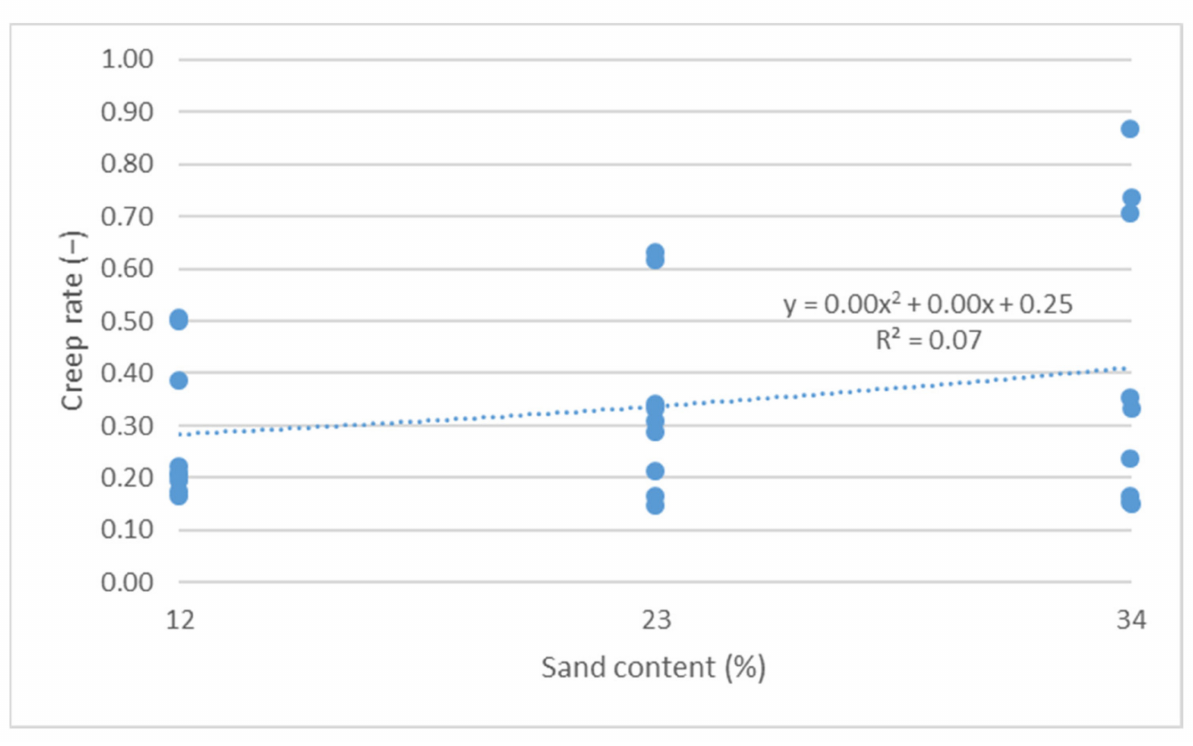
Figure 6. Creep rate vs. sand content.